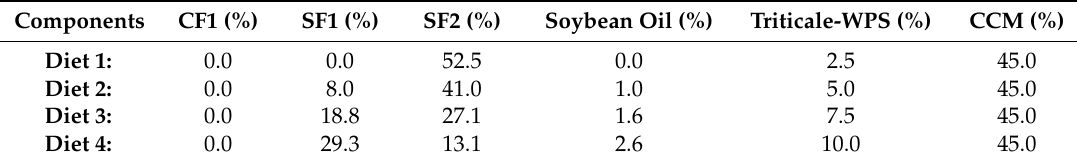
Table 2. Components given in Barn I and II to experimental groups fed at an average bodyweight of 70 kg. Components